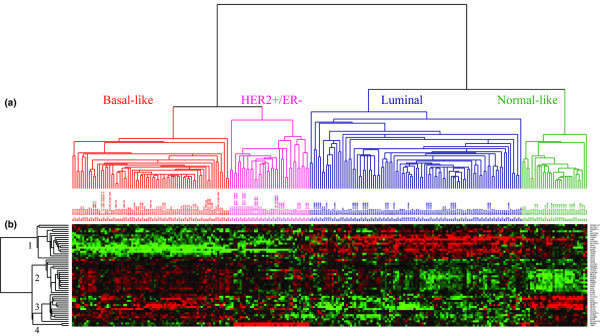
Co-clustering of real-time quantitative reverse-transcription (qRT)-PCR and microarray data using 50 genes and 252 samples. The relative copy number (qRT-PCR) and R/G ratio (microarray) for each gene was log2-transformed and combined into a single dataset using distance-weighted discrimination. Two-way hierarchical clustering was performed on the combined dataset using Spearman correlation and average linkage. (a) The sample-associated dendrogram shows the same classes as seen in Figure 1. Samples are classified as Basal-like (red), HER2+/ER- (pink), Luminal (blue), and Normal-like (green). The expression level for each gene is shown relative to the median expression of that gene across all the samples, with overexpressed genes in red and underexpressed genes in green. Genes with average expression are black. (b) The gene-associated dendrogram shows that the Luminal tumors and Basal-like tumors differentially express estrogen-associated genes (cluster 1); as well as basal keratins (KRT 5 and KRT 17), inflammatory response genes (CX3CL1 and SLPI), and genes in the Wnt pathway (FZD7) (cluster 3). The main distinguishers of the HER2+/ER- group are low expression of genes in cluster 1 and high expression of genes on the 17q12 amplicon (ERBB2 and GRB7) (cluster 4). The proliferation genes (cluster 2) have high expression in the estrogen receptor (ER)-negative tumors (Basal-like and HER2+/ER-) and low expression in ER-positive (Luminal) and Normal-like samples.